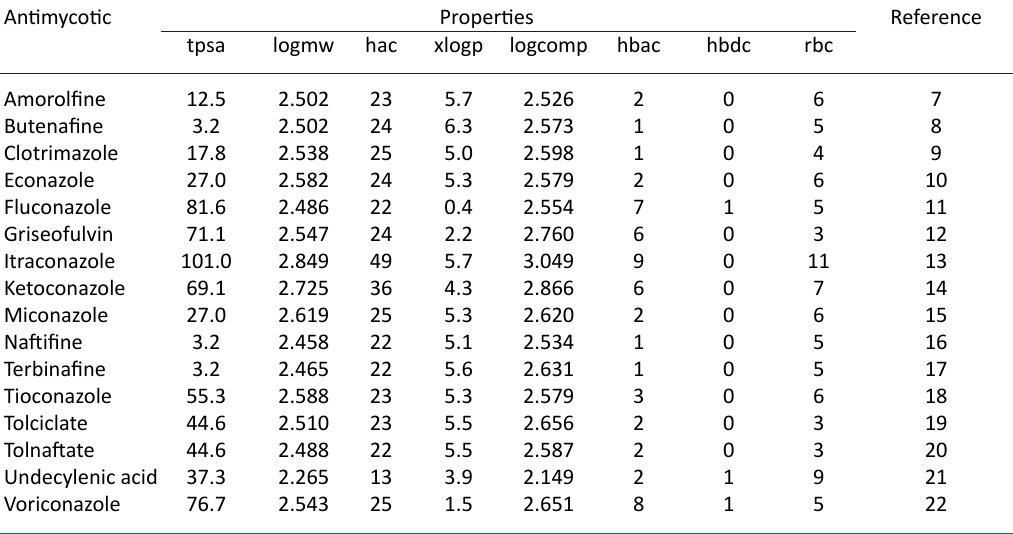
Table 1. Descriptors of the different antimycotics. Antimycotic Properties